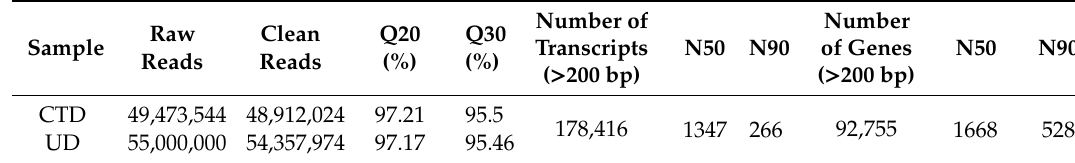
Table 2. RNA sequencing analysis in CTD and UD RNA libraries.